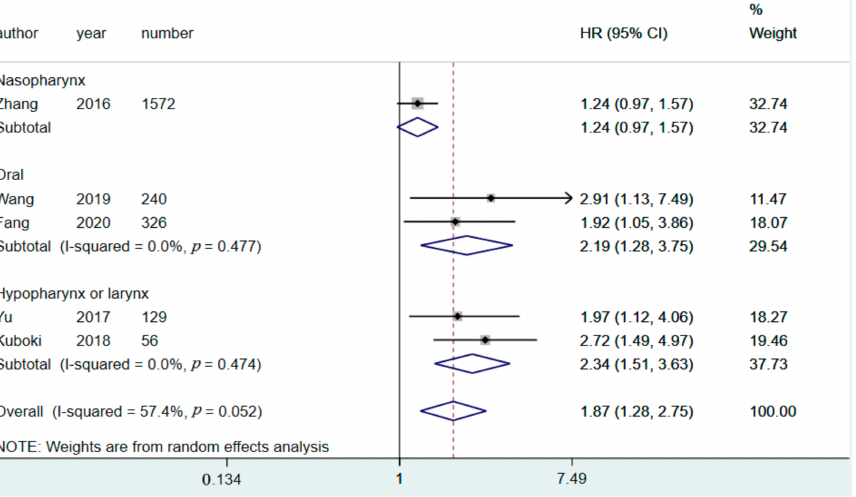
Figure 4. Forest plot showing the pooled results of HRs of DFS for various tumor locations. HR, hazard ratio; CI, confidence interval; DFS, disease-free